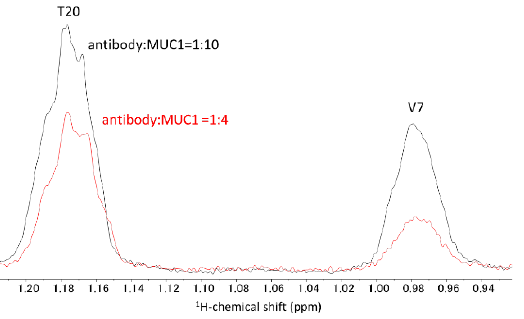
Figure 3. NMR titration experiments using MUC1 (20AA) and MY.1E12. The methyl region is selected to show T20 and V7 methyl signals (black; antibody:MUC1 = 1:10, red; antibody:MUC1 = 1:4). The experiments were performed on a 600 MHz spectrometer at 278 K.